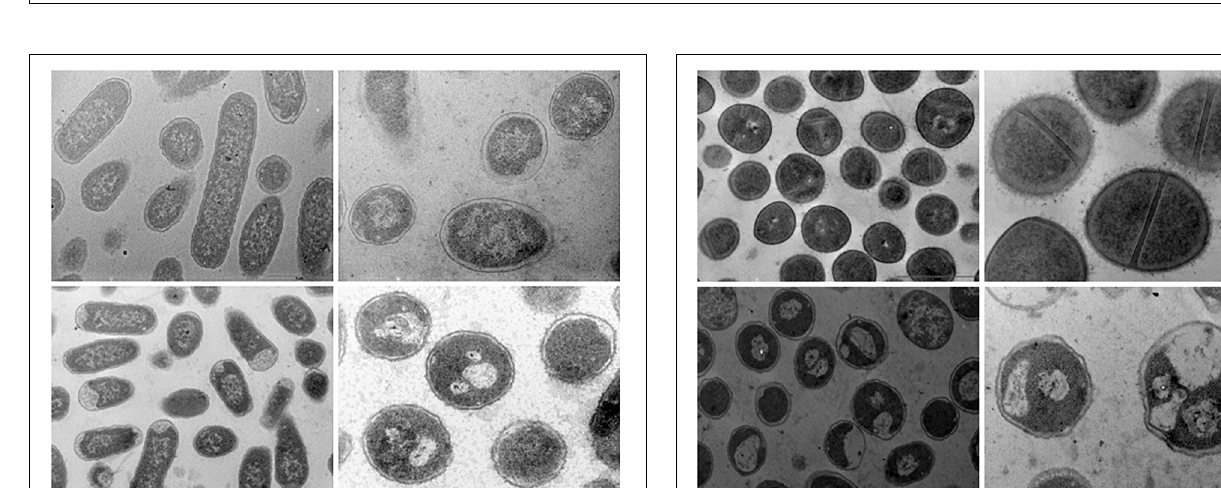
FIGURE 4 | Scanning electron micrographs (SEM). Above, MRSA-N315 control, great number of bacteria with intact appearance and high extracellular polysaccharide production. Below, MRSA-N315 strain treated with Fluopsin C (1 h), showing less bacteria and extracellular matrix.